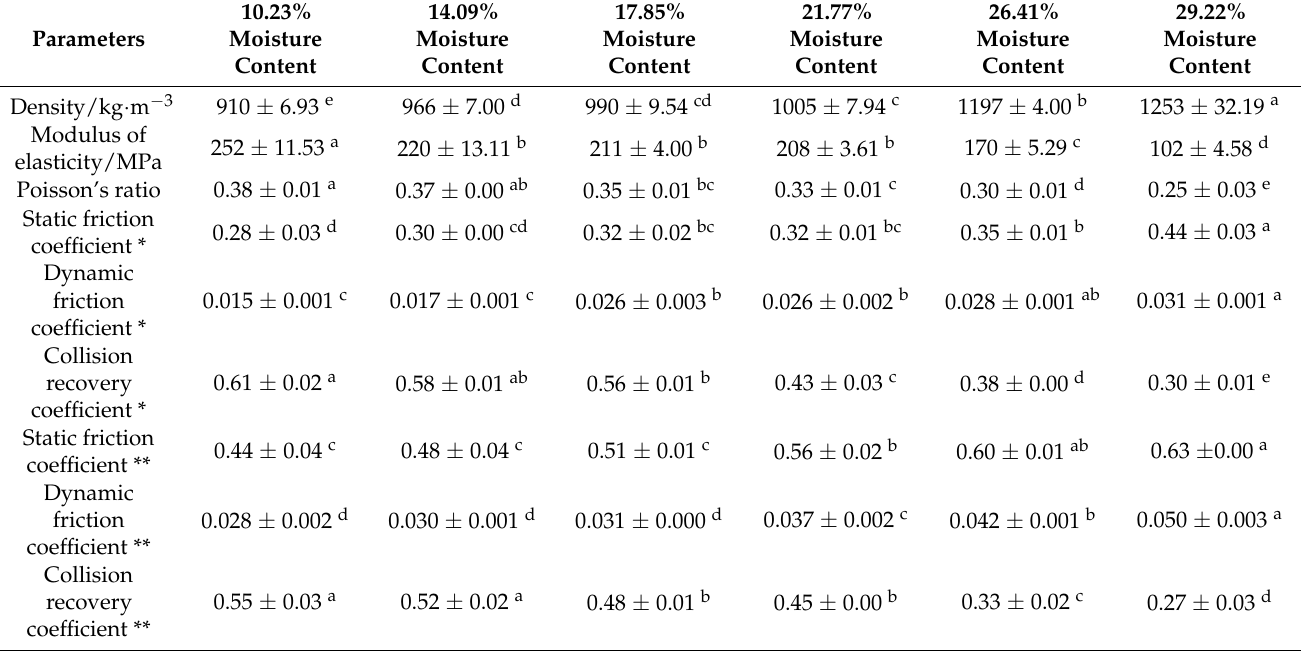
Table 1. Mean values ( ± standard error) of measuring results of parameters at different moisture contents of rice